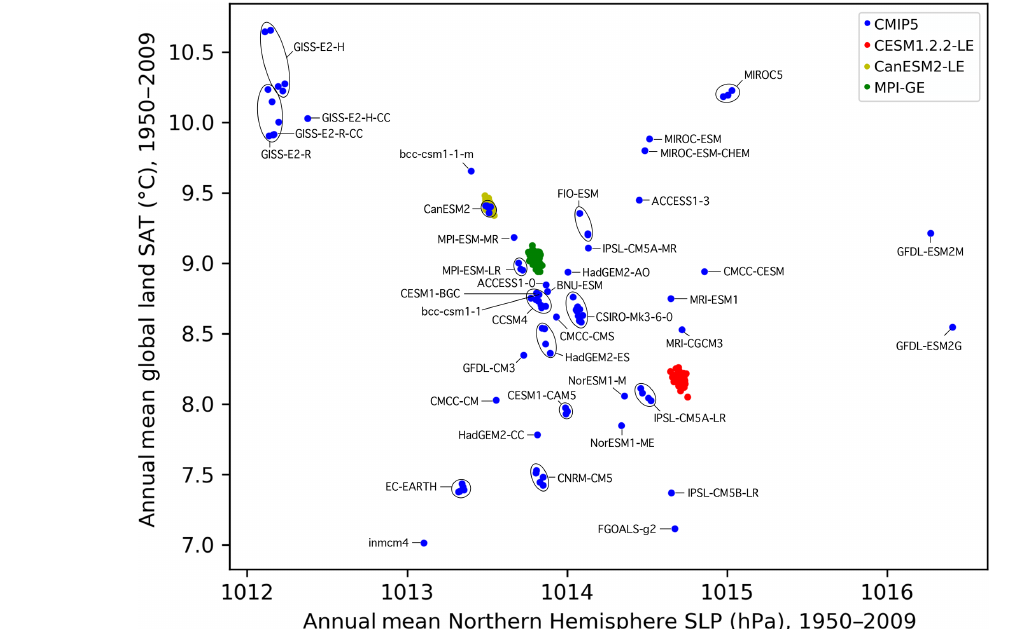
Figure 5. Scatter plot showing how ALL ensemble members distribute in the Northern Hemisphere SLP climatology and global land SAT climatology predictor space. Members and IC ensembles within the CMIP5 ensemble (blue) are labeled by model name. The CESM1.2.2-LE is indicated in red, the CanESM2-LE is indicated in yellow, and the MPI-GE is indicated in green, consistent with other figures.